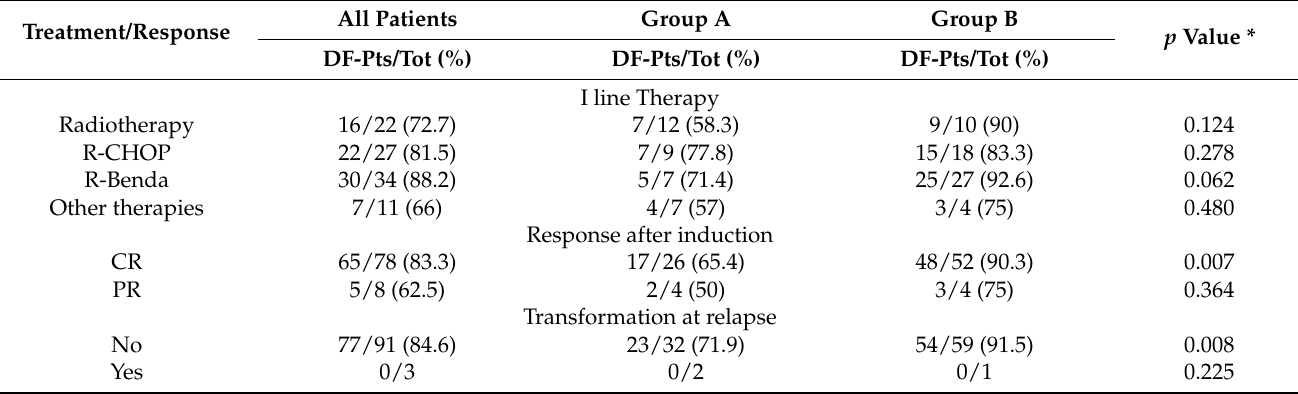
Table 3. Comparison of the PFS between Group A and Group B in relationship to I line therapy adopted and response achieved at the end of induction. Sub-analysis was performed for those patients with transformation to high-grade lymphoma at